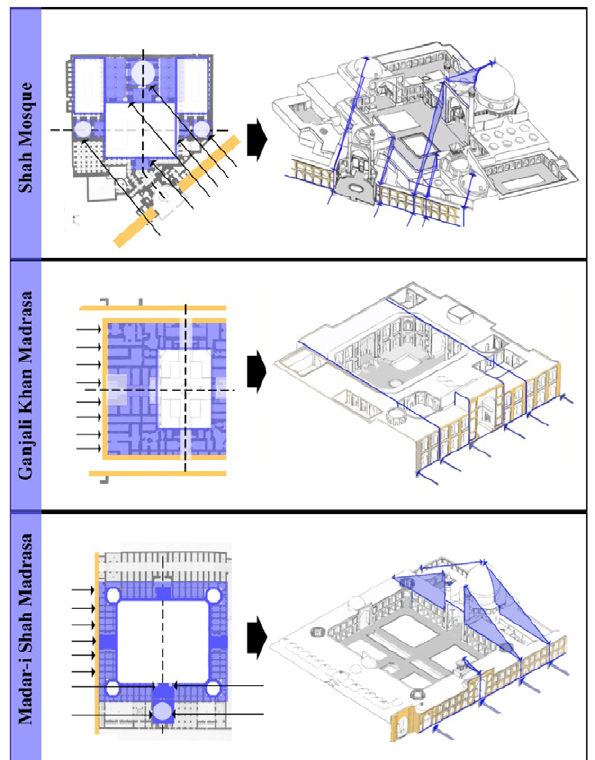
Figure 8. Some orders of the unit combinations are in line with manifesting the reality of distributed elements on the sides of the civic